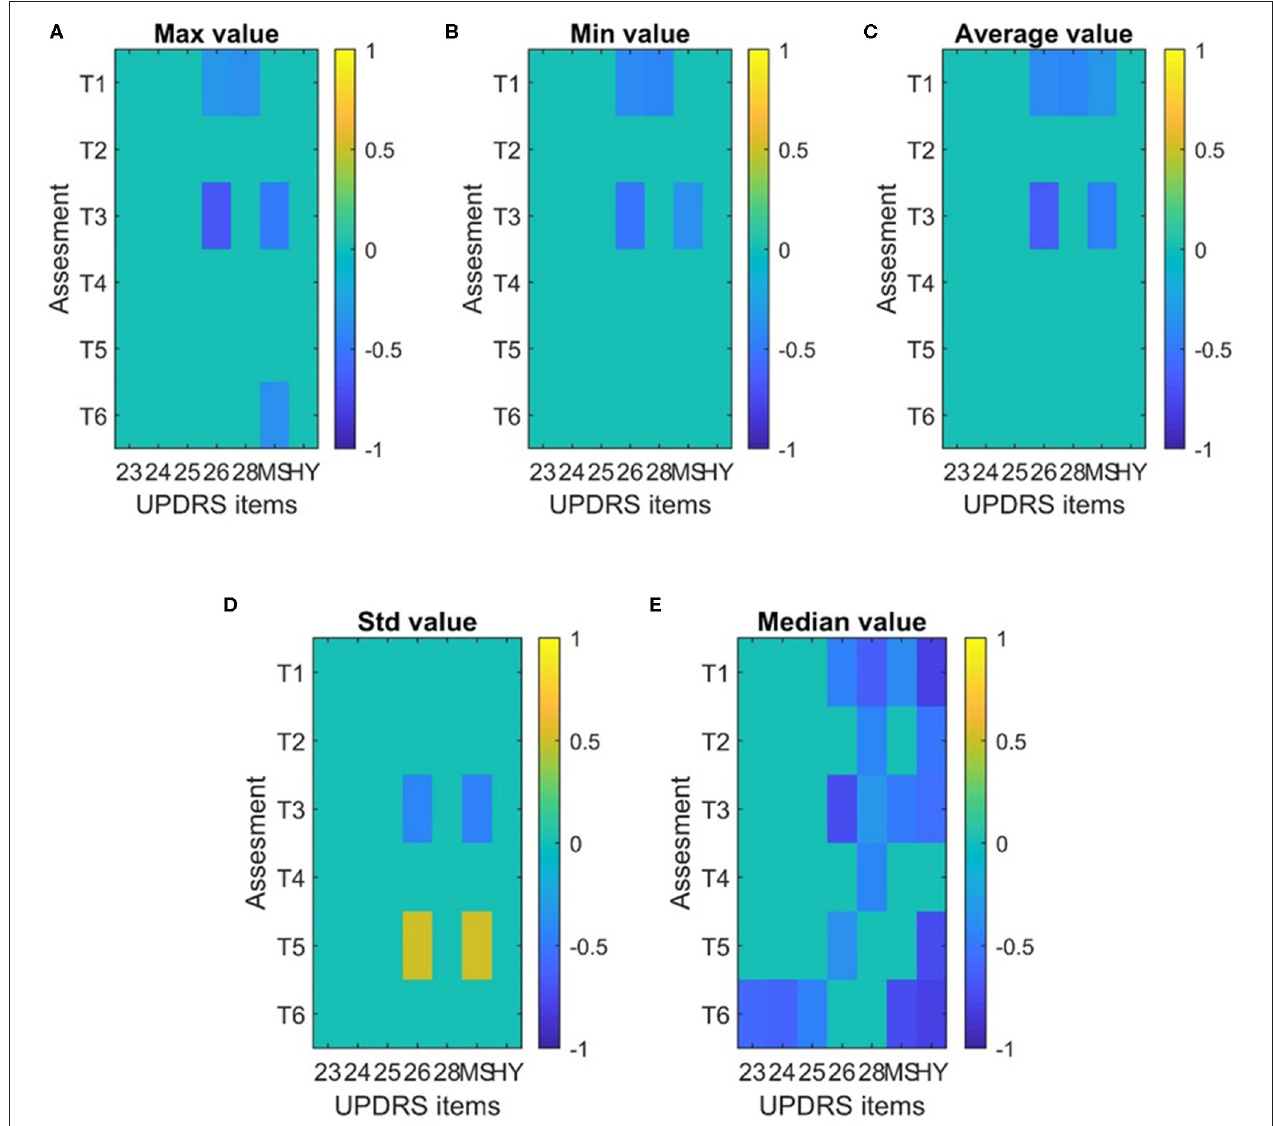
FIGURE 5 | Correlation analysis results ( r matrix) between the UPDRS Part III items and the features extracted from the Assessment Tests FinalMotorScore data, i.e., (A) Max value, (B) Min value, (C) Average value, (D) Std value, and (E) Median value. Inactive and active r matrix elements are defined as (p > a; r = 0) and ( p < a; r ∈ [-1,l] r 6= o ),